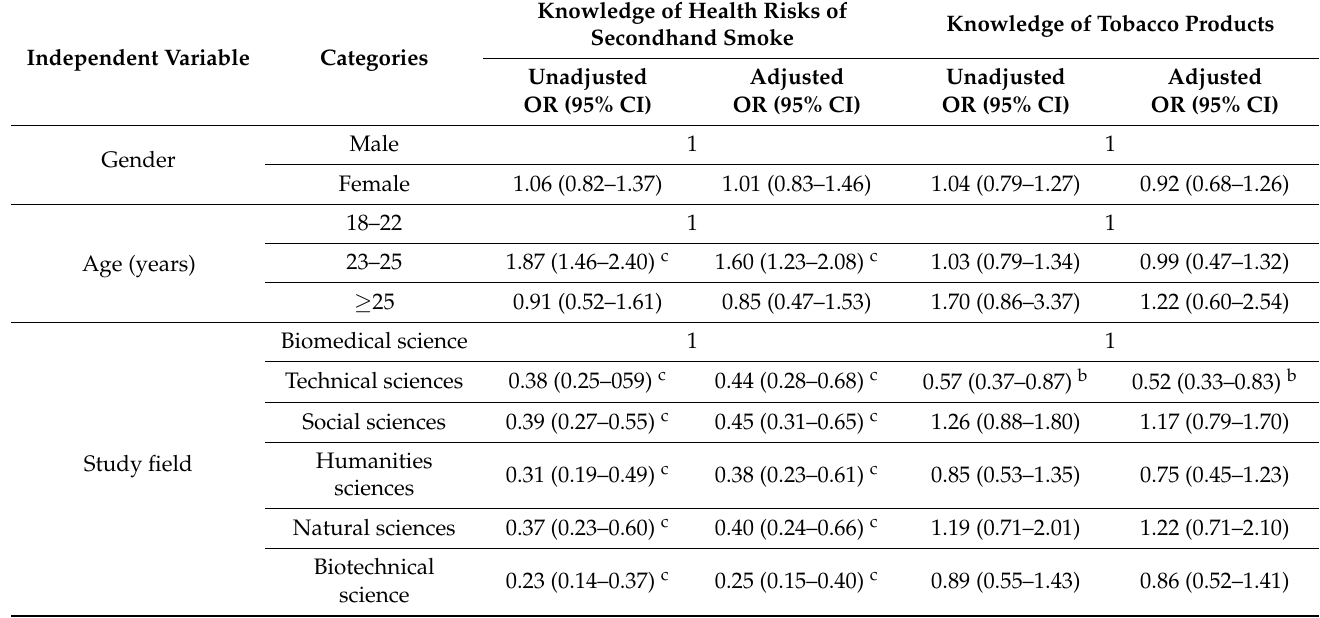
Table 5. Unadjusted and adjusted odds ratios for the associations of participants’ characteristics with and health risks of secondhand smoke and the knowledge of tobacco